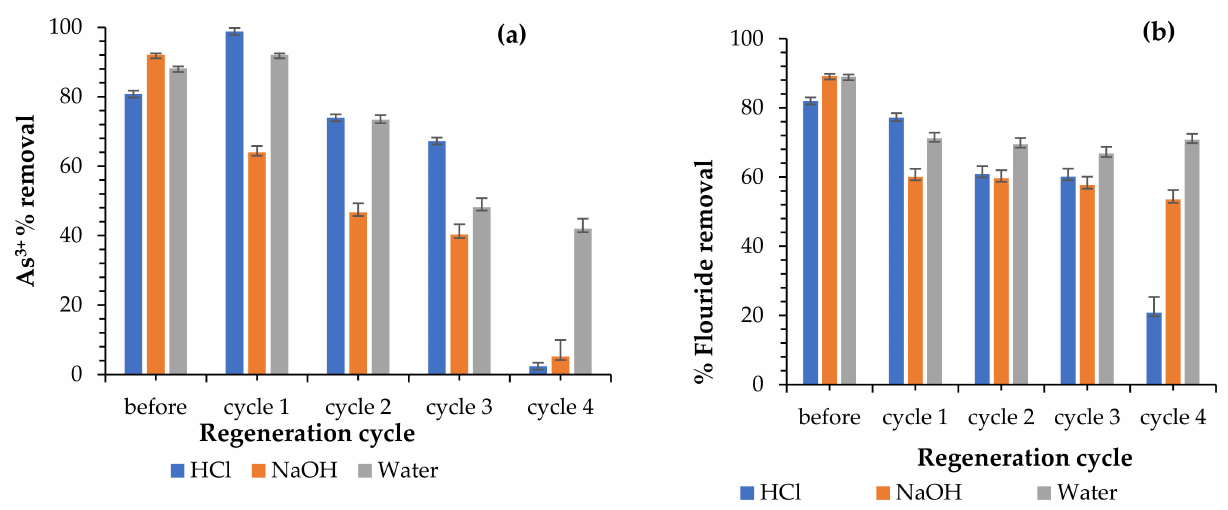
Figure 13. Regeneration results ( a ) As 3+ and ( b ) F − (initial F − and As 3+ concentration: 5 and 10 mg/L; adsorbent dose: 0.25 and 0.2 g; solution volume: 50 mL; contact time: 40 min; shaking speed: 250 rpm; and temperature: 297